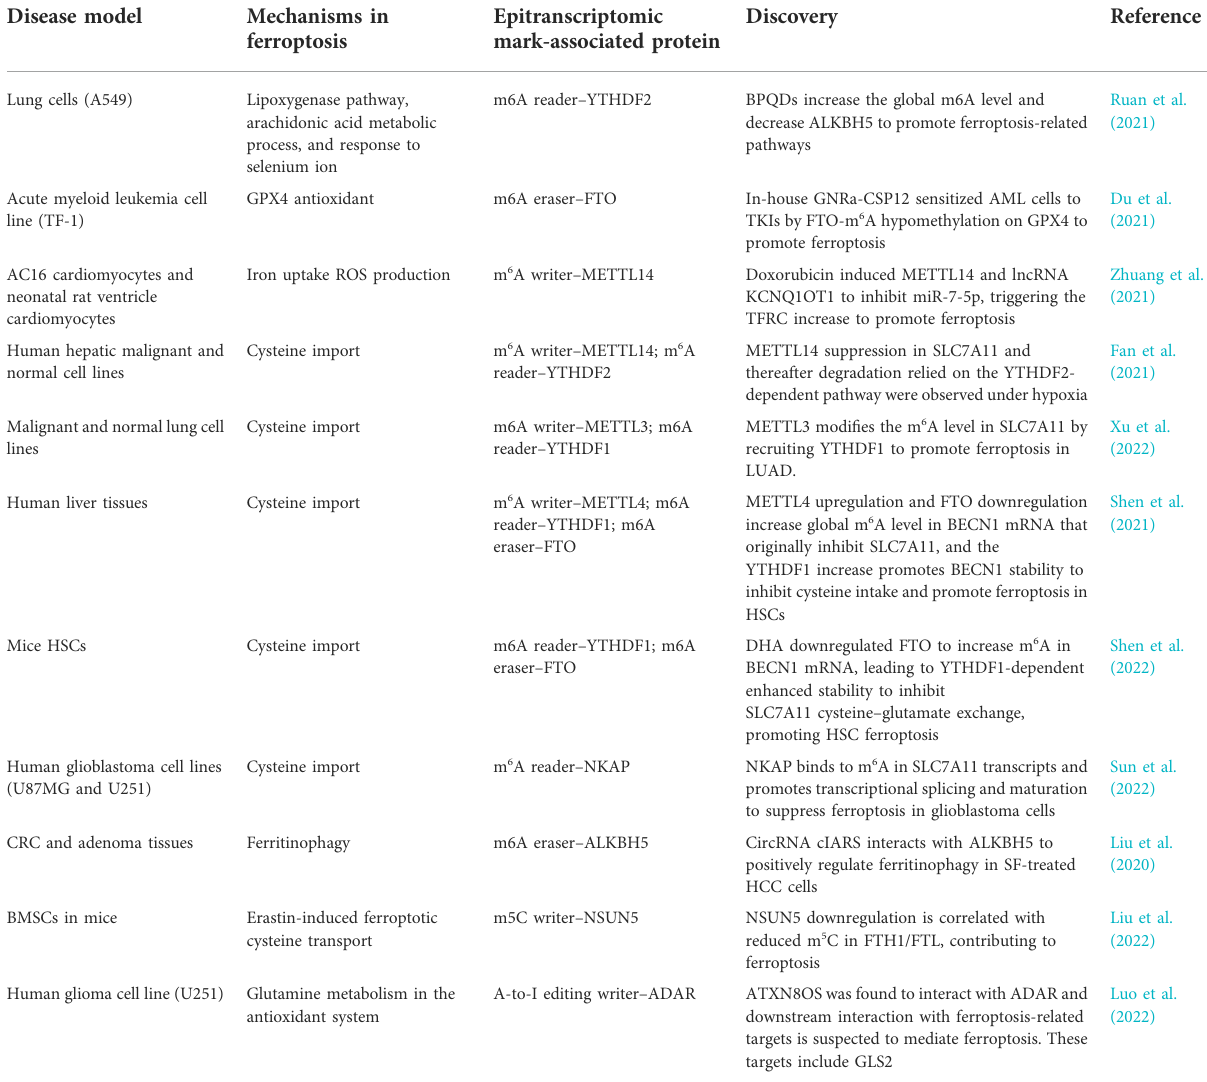
TABLE 2 Discovered epitranscriptomic marks on ferroptosis-related